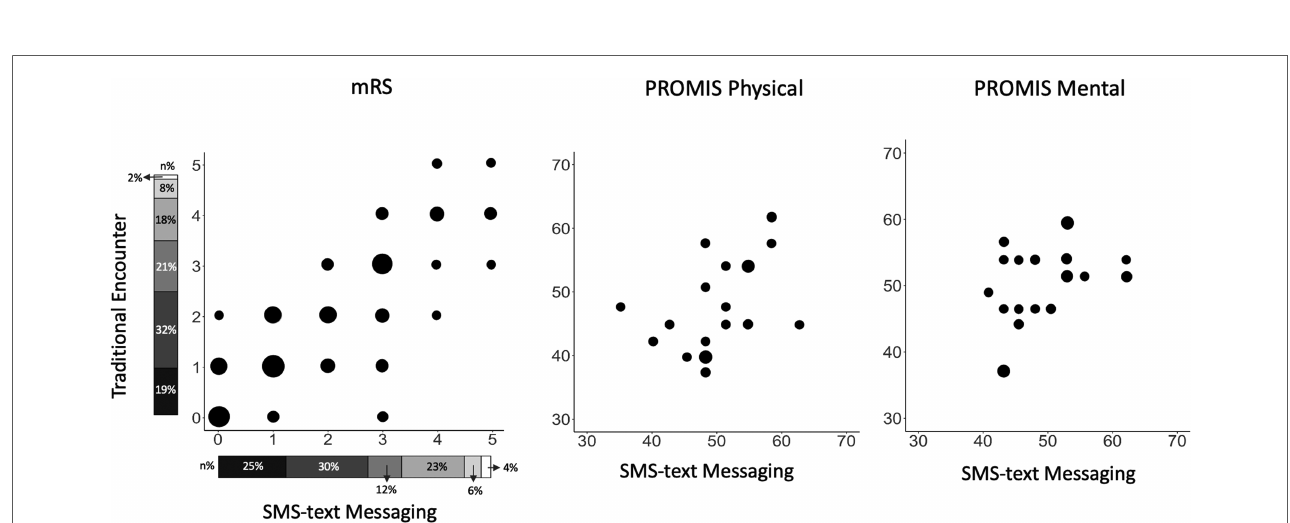
FIGURE 4 ( A ) mRS compared by modality (traditional encounter vs. SMS texting) across all collection time points (30, 60, and 90 days) for N =113. Bubble plot to assess agreement between outcomes collected by traditional programs vs. SMS texting. Sizes of bubbles are directly proportional to the number of participants who provided answers via traditional methods and SMS texting. Subjects with data at multiple time points were compared at the latest available time point. The stacked bar near axes shows mRS distributions as collected by each modality with dark to light gradient representing scores 0 – 5, respectively. ( B ) PROMIS Physical and PROMIS Mental compared by modality for N =19. Bubble plot to assess agreement between outcomes collected by traditional programs vs. SMS texting. The size of bubbles is directly proportional to the number of participants who provided answers via traditional methods and SMS